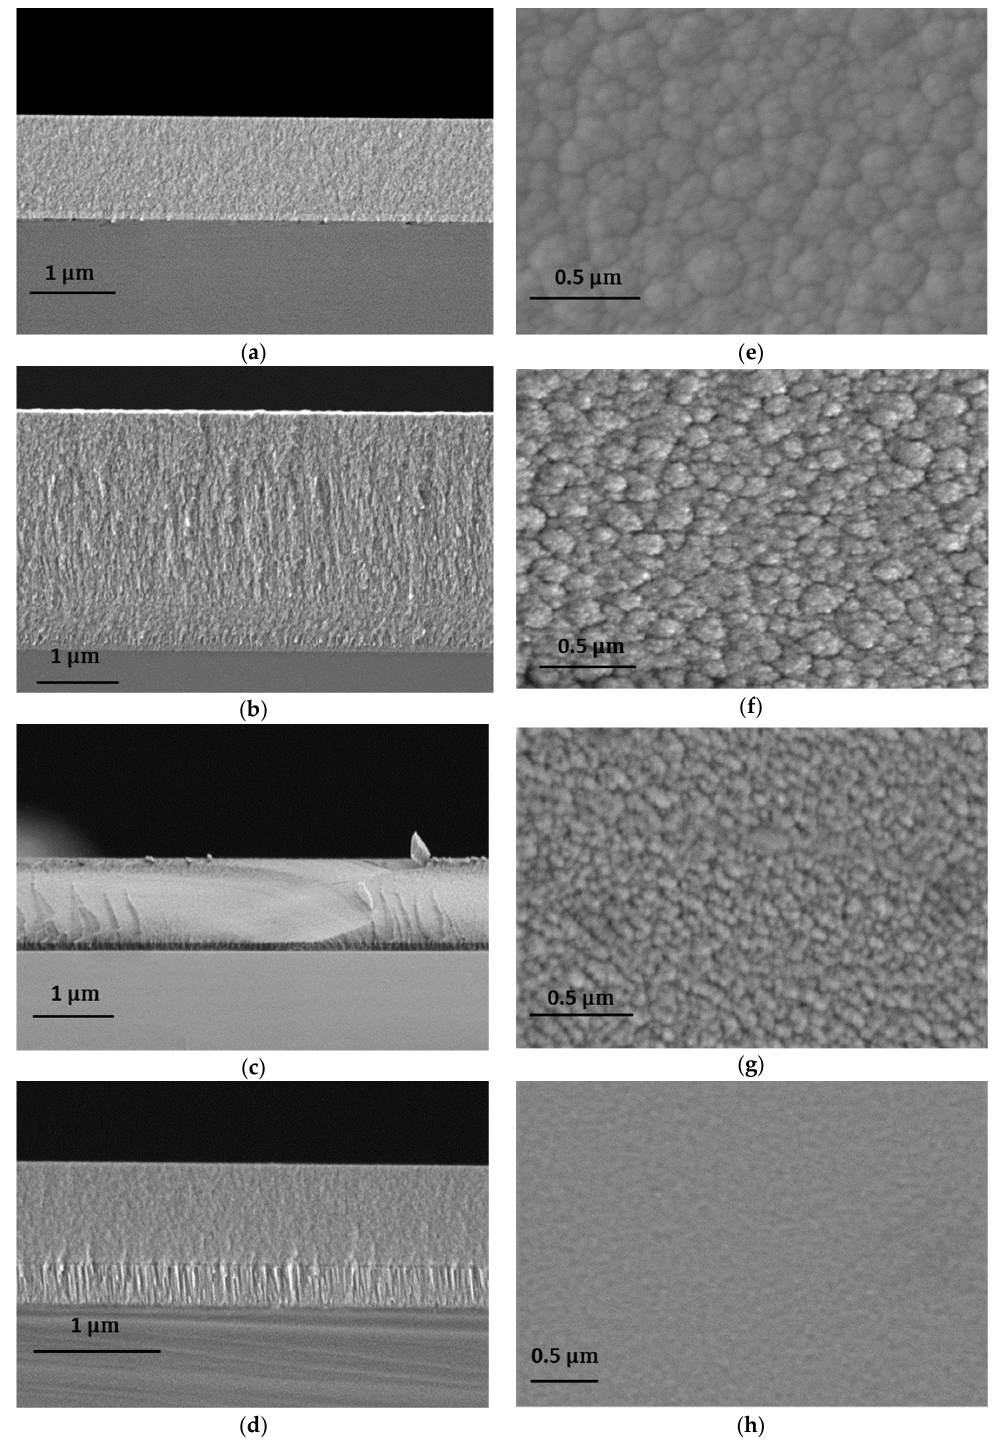
Figure 2. Cross-sectional SEM micrographs of: ( a ) D1-450; ( b ) D2-17; ( c ) D3-17; ( d ) D4-38; and their respective top-surface morphologies ( e ) D1-450; ( f ) D2-17; ( g ) D3-17; ( h ) D4-38.